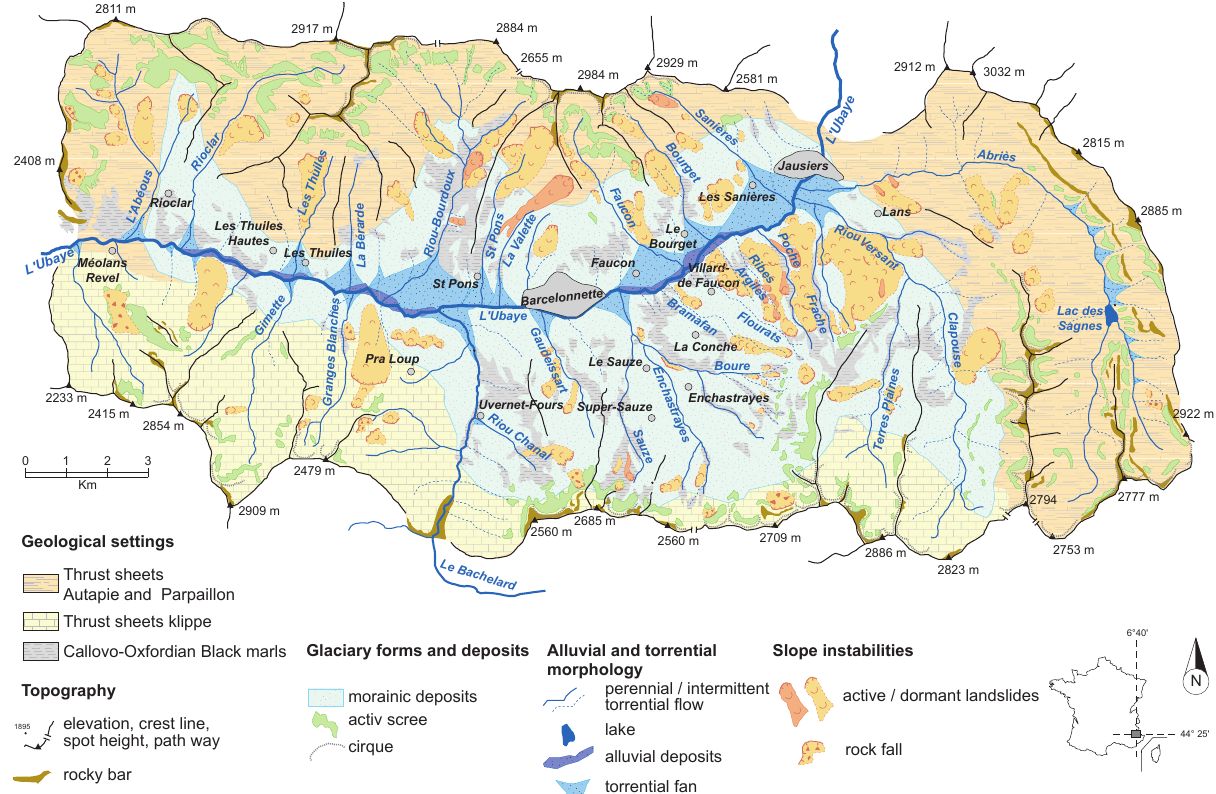
Fig. 3. Geomorphological map of the Barcelonnette Basin depicting the extent of the torrential fans, after Remaˆıtre (2006).